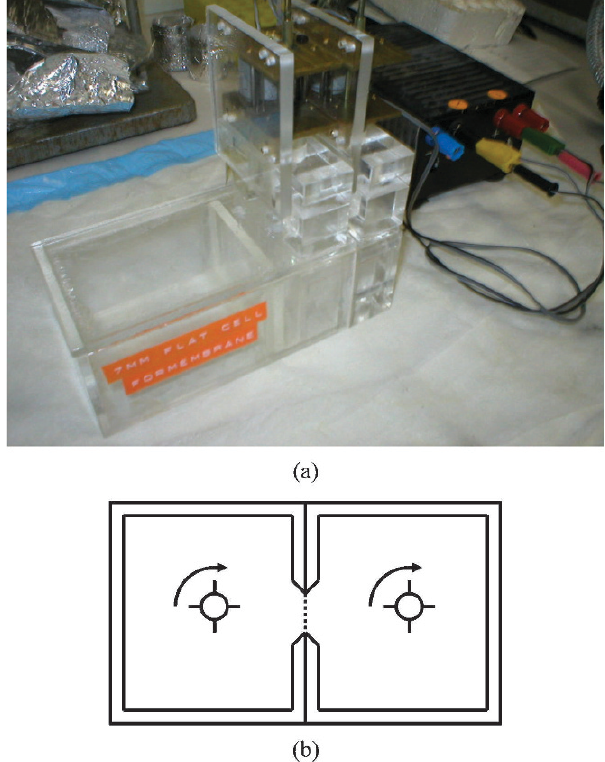
Figure 1 - The two-chamber device that was used in the experiments (a) and a schematic diagram of the device (b). The dotted line between the two chambers indicates the